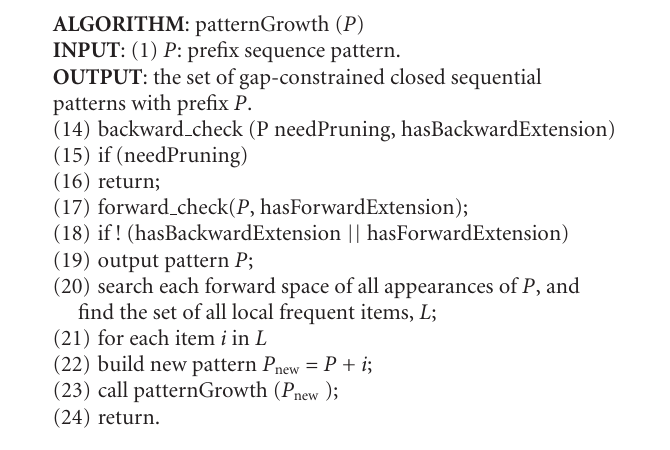
Algorithm 3 iteratively. Algorithm 3 patternGrowth ( P )